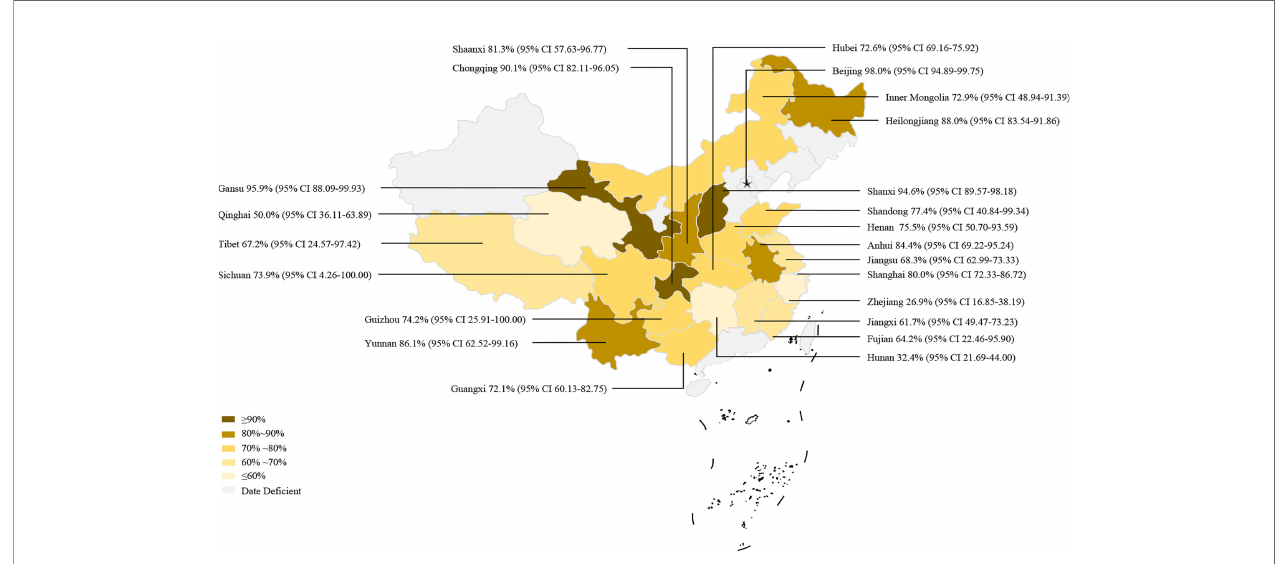
FIGURE 5 | Map of Eimeria spp. in goats amongst studies conducted in